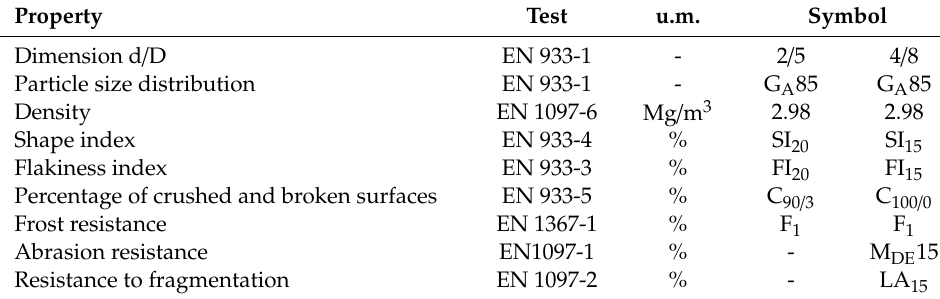
Table 3. Properties of gabbro aggregates 2/5 and 4/8.